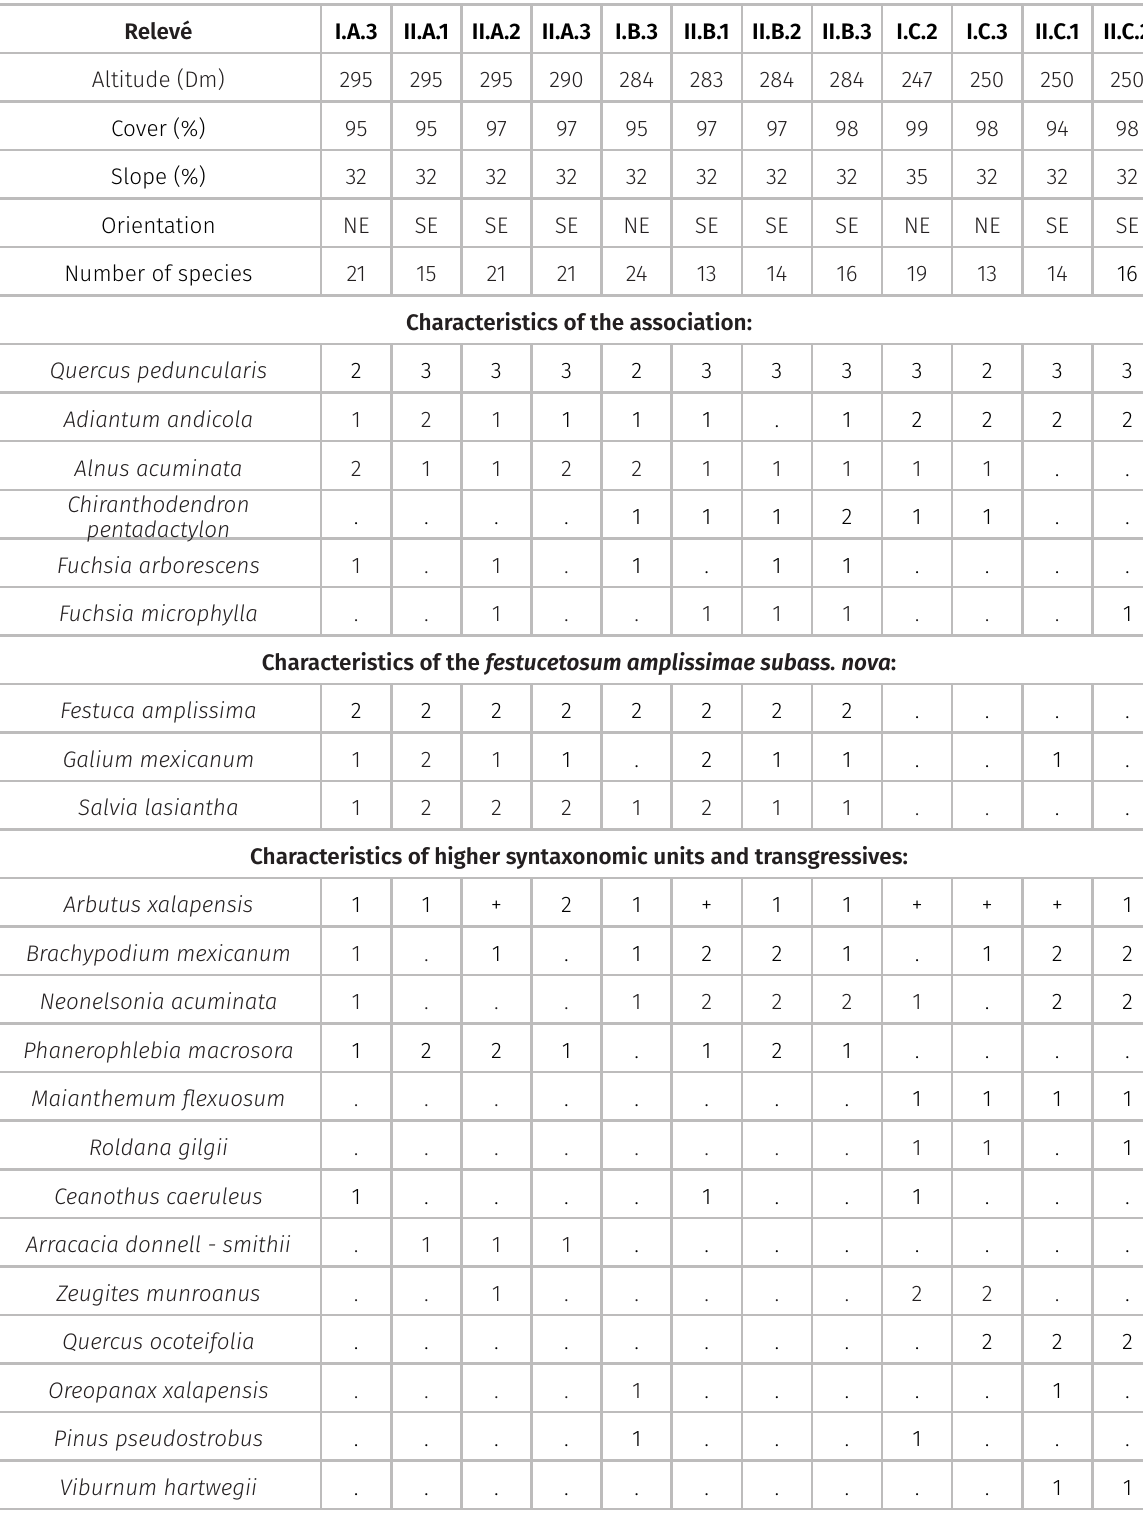
Characteristics of the association: